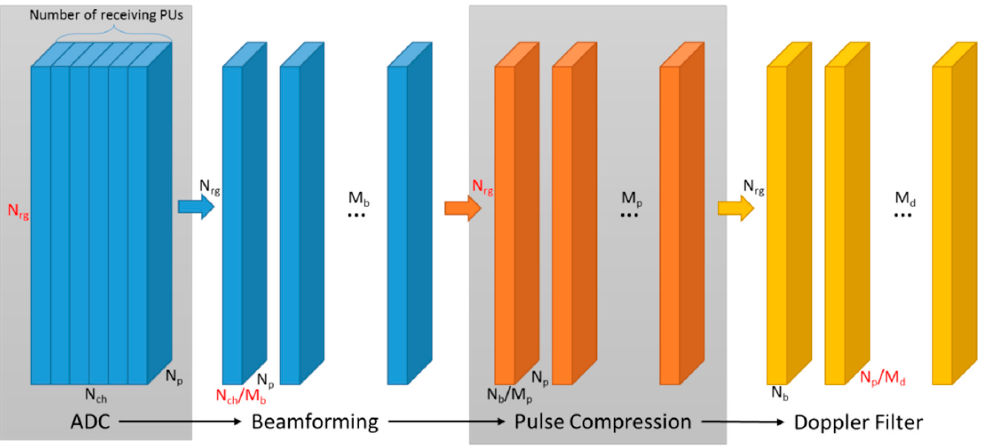
Figure 3. Overview of the non-adaptive, “core data cube” processing chain in a general digital array radar.